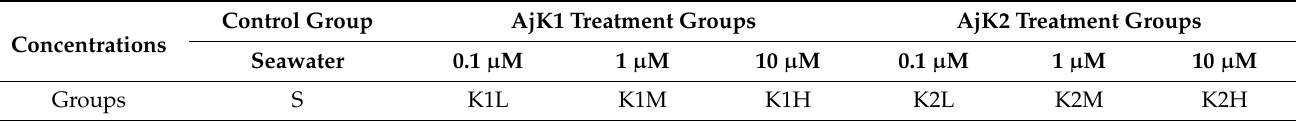
Table 1. Experimental groups. Each treatment set had three concentrations. Control Group AjK1 Treatment Groups Concentrations